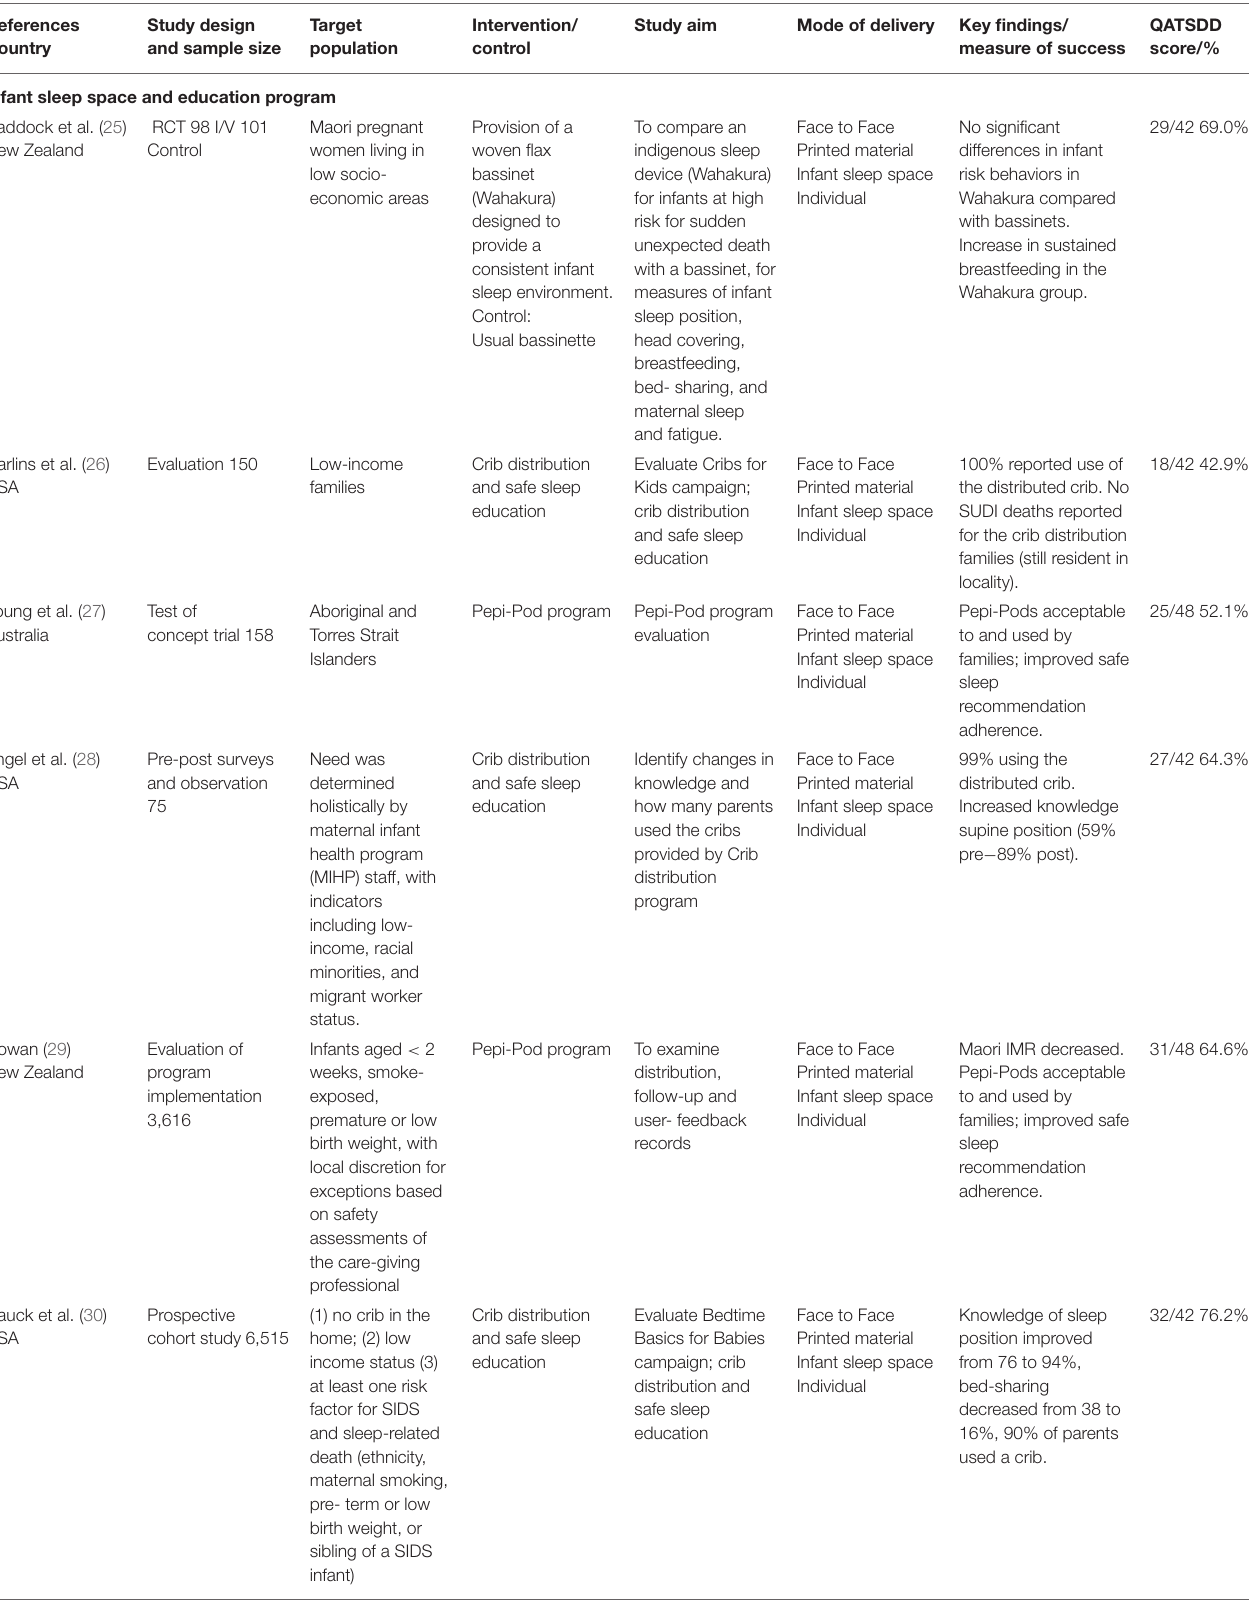
TABLE 1 | Characteristics of included interventions to reduce the risk of SUDI in families with children considered to be at high